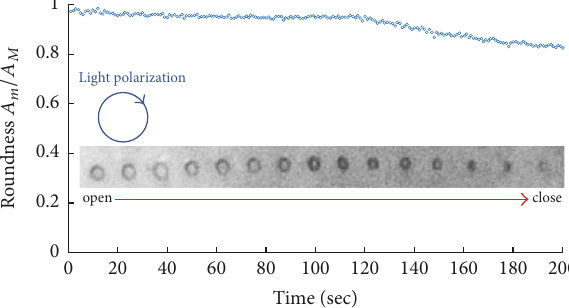
Figure 4: Time-resolved roundness evolution microwells during laser irradiation with circularly polarized light. In the inset, optical images of individual microwells are exposed to different light